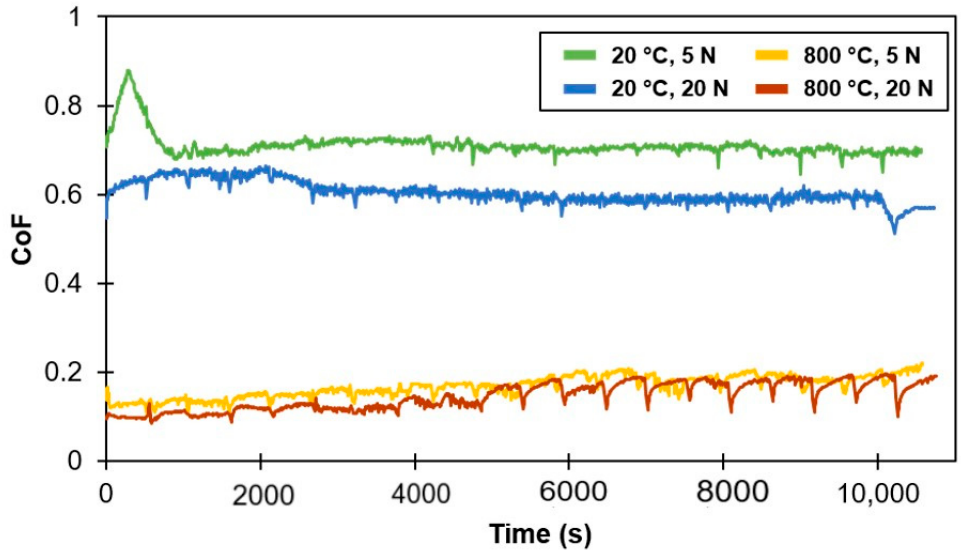
Figure 5. Effect of temperature and load on evolution of coefficient of friction.